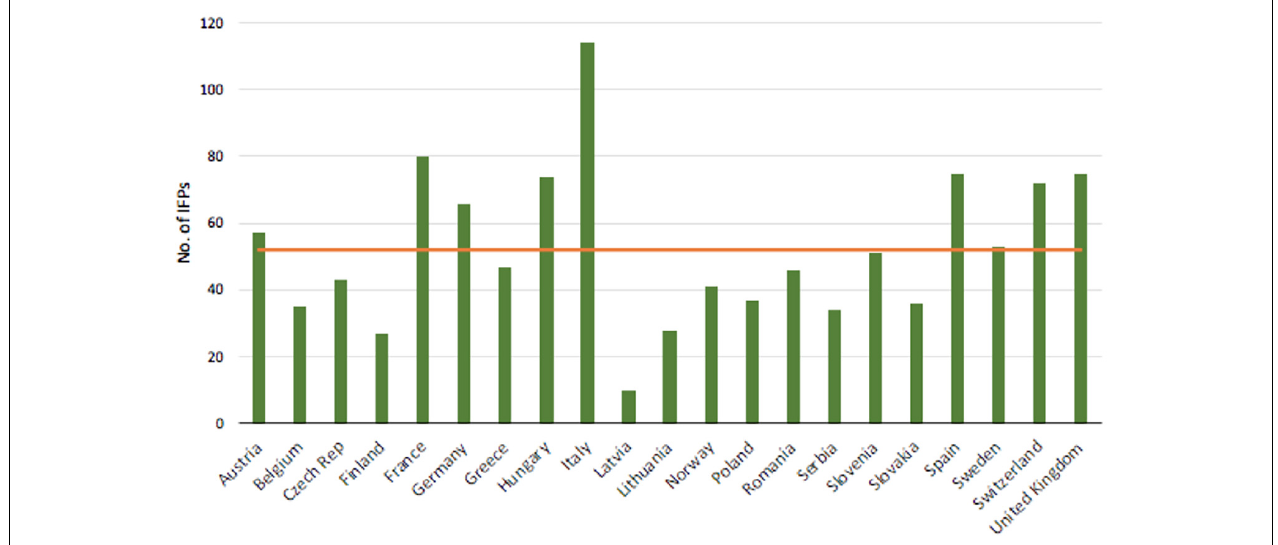
FIGURE 4 | Total number (columns) and average (line) of IFPs since 1800 (mod. from Santini et al.,